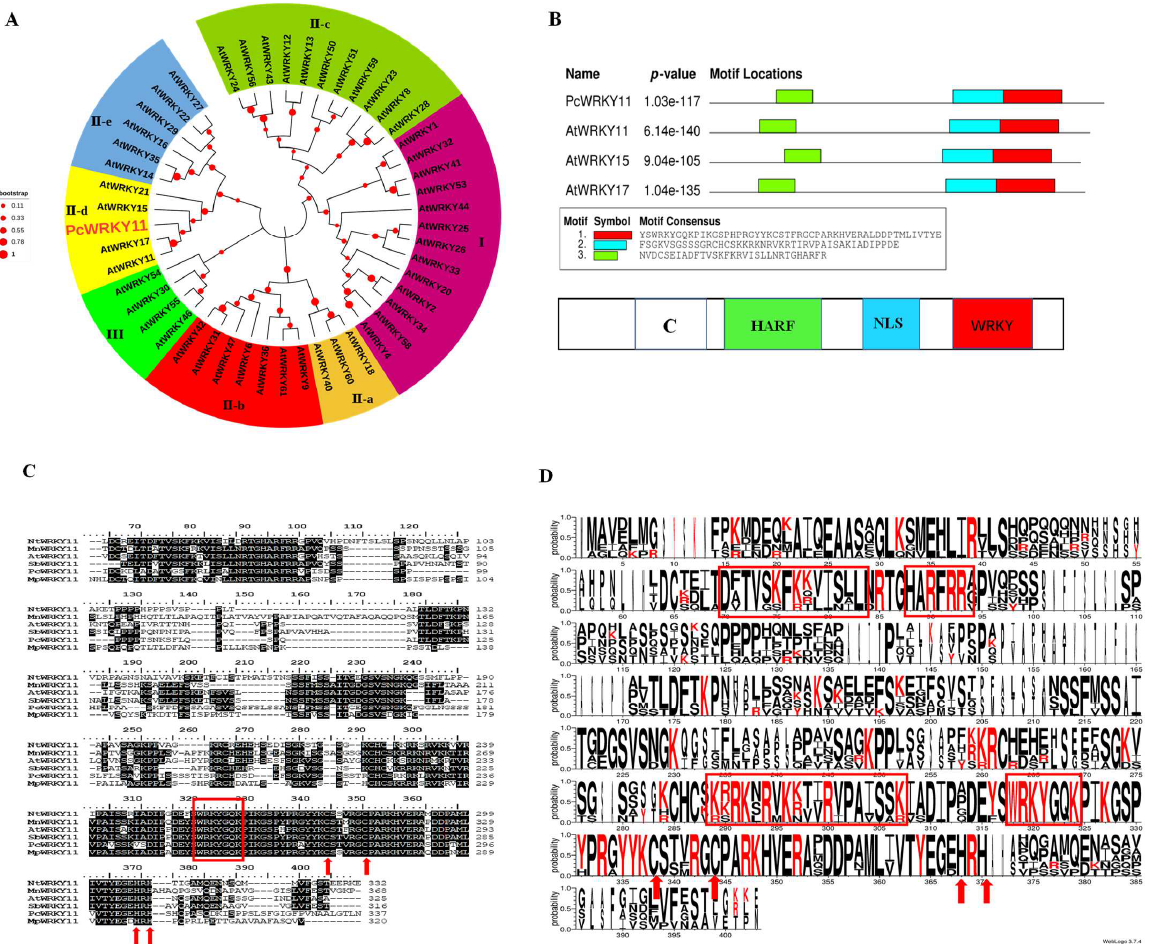
Figure 1. Bioinformatics analysis of PcWRKY11 . ( A ) Phylogenetic tree of the PcWRKY11 and AtWRKY protein family. The amino acid sequences were subjected to Clustal W using the neighbor-joining method in MEGA X; PcWRKY11 is marked with red enlarged font; At, Arabidopsis thaliana ; Pc, Polygonum cuspidatum . ( B ) The schematic diagram of the II-d WRKY conserved domain. White: binding domain with calmodulin, green: II-d WRKY characteristic domain, blue: nuclear localiza- tion domain, red: WRKY characteristic domain. ( C ) Sequence alignment of PcWRKY11 to other plant WRKY11. Identical amino acids are shaded in color, the WRKYGQK conservative sequence is outlined by a box, and the C and H residues in the zinc-finger motif are marked by an arrow; Nt, Nicotiana tabacum ; Mn, Morus notabilis ; At, Arabidopsis thaliana ; Sb, Soy beans ; Pc, Polygonum cuspida- tum; Mp, Mucuna pruriens. ( D ) Visualization of the result of the sequence similarity of PcWRKY11 to the other plant WRKY11. The larger the letter, the more conservative the amino acid. Shared conserved domains are boxed in red. To further confirm the nomenclature correctness of PcWRKY11 , sequence compari- son with WRKY11 from other species, including NtWRKY11 (A0A1U7W174), AtWRKY11 (A0A1P8B8D0), SbWRKY11 (A0A445EXZ3), MpWRKY11